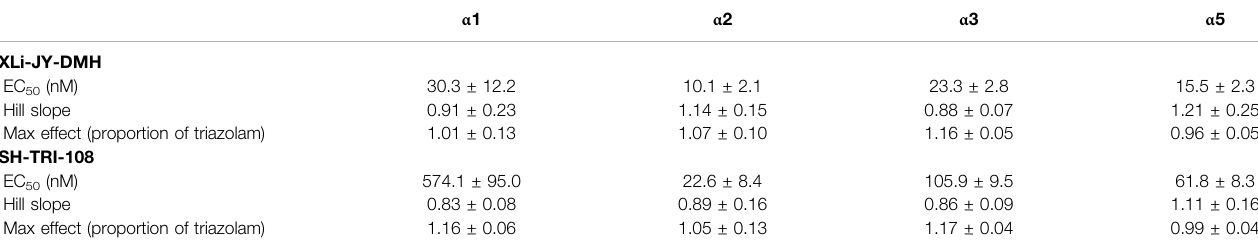
TABLE 4 | Intrinsic ef fi cacy and potency of benzodiazepine receptor ligands at recombinant GABA A receptors containing α X β 3 γ 2 subunits based on all data converted to proportion of triazolam . α 1